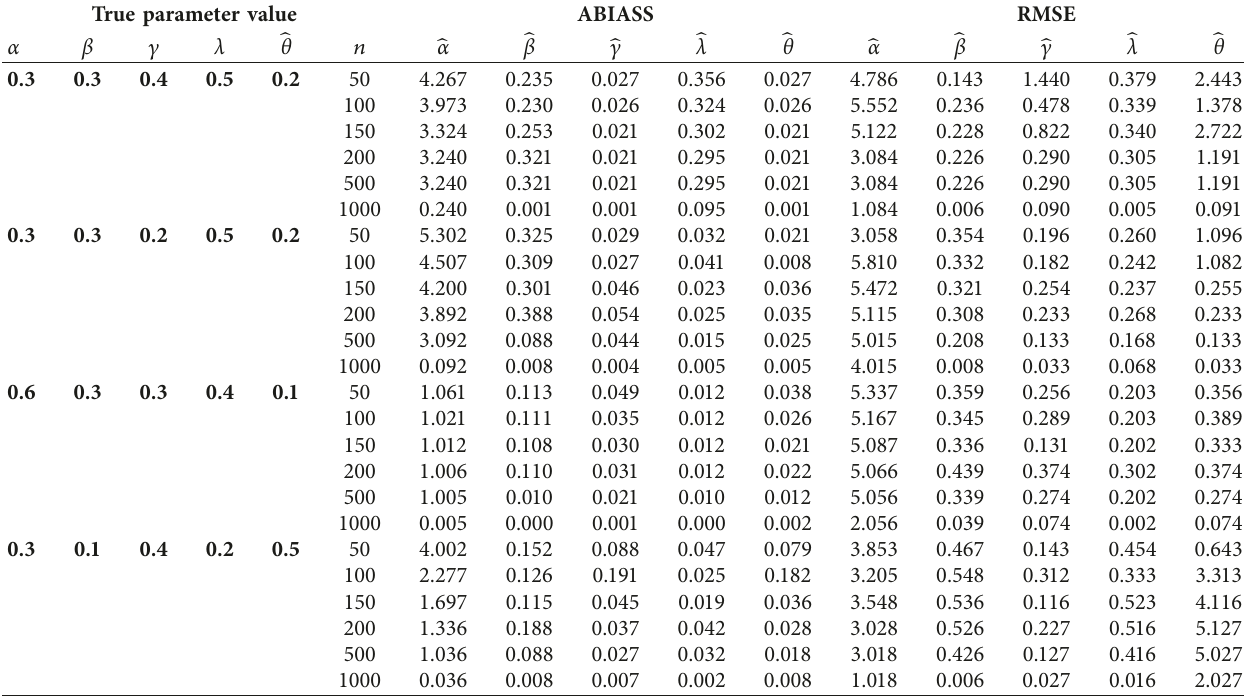
Table 1: Monte Carlo simulation results of